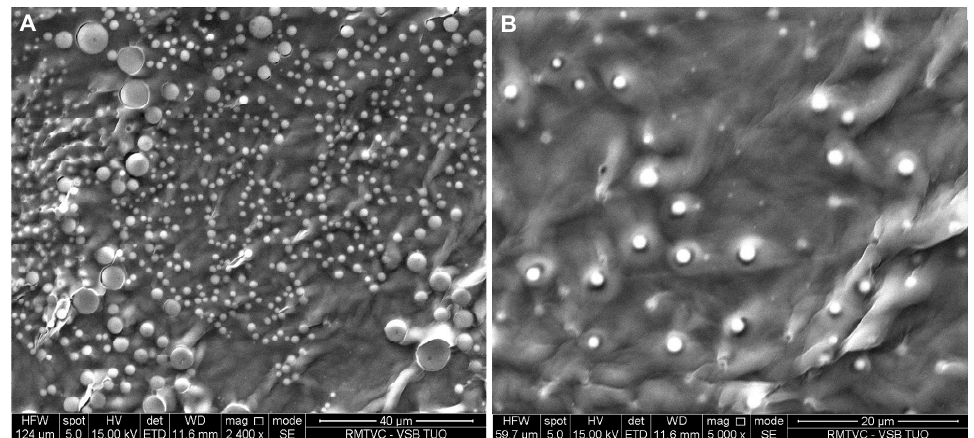
Figure 9. SEM image of risedronate with macrogol 6000 (Sample 3c ) at magnification 2400× ( A ) and 5000× ( B ).